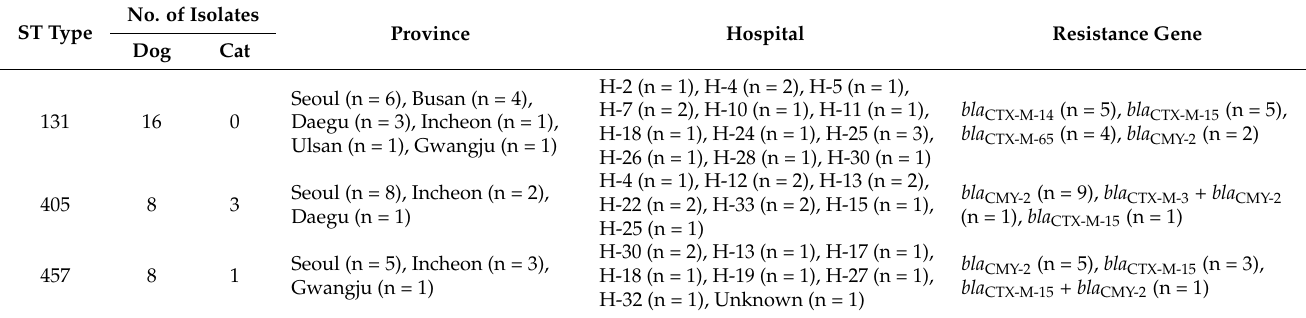
Table 5. MLST profiles ESBL/AmpC-producing E. coli isolated from diseased dogs and cats in